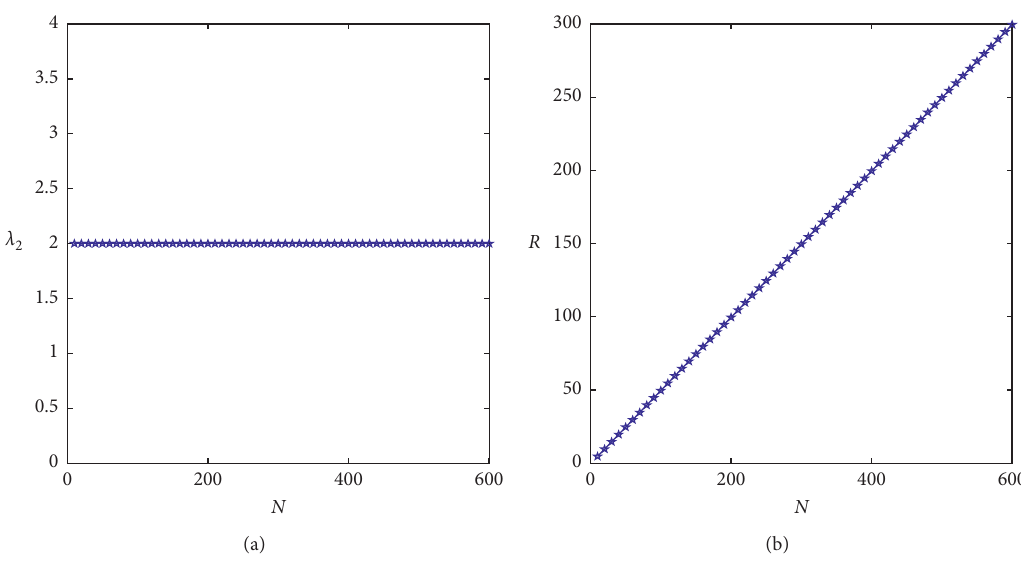
Figure 15: When N is even, the synchronizability of Network II changes with the number of subnetwork nodes N . (a) λ changes from 10 to 600); (b) R changes with N ( N changes from 10 to 600).